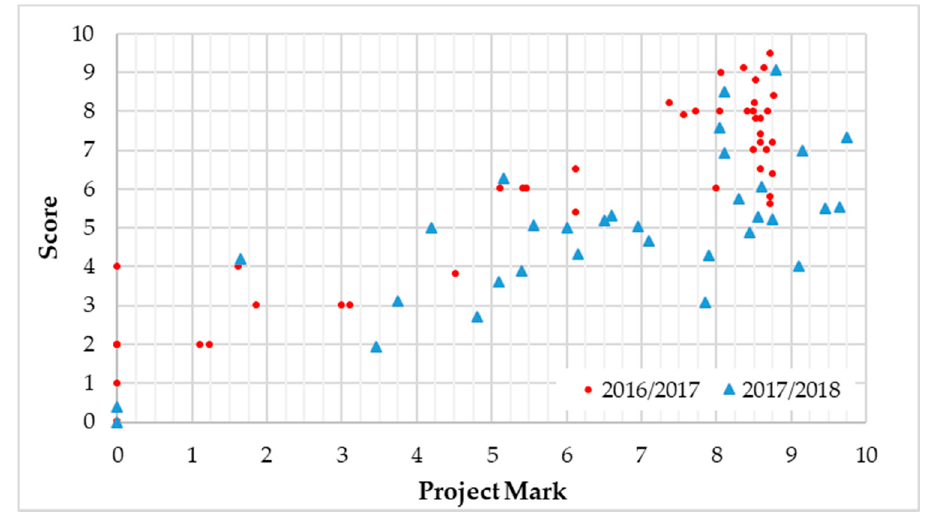
Figure 4. Relationship between the exam and project marks in hydraulic machines.